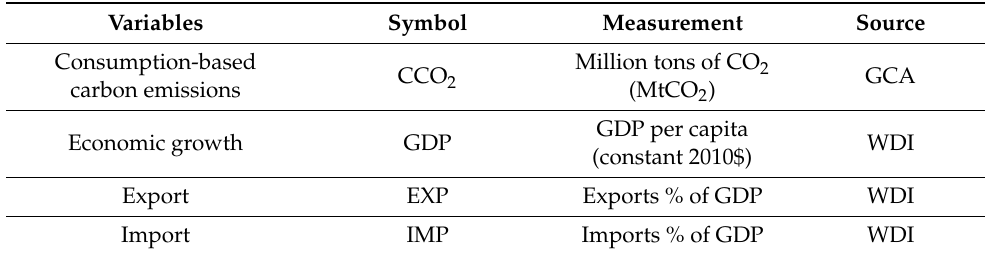
Table 2. Data description.